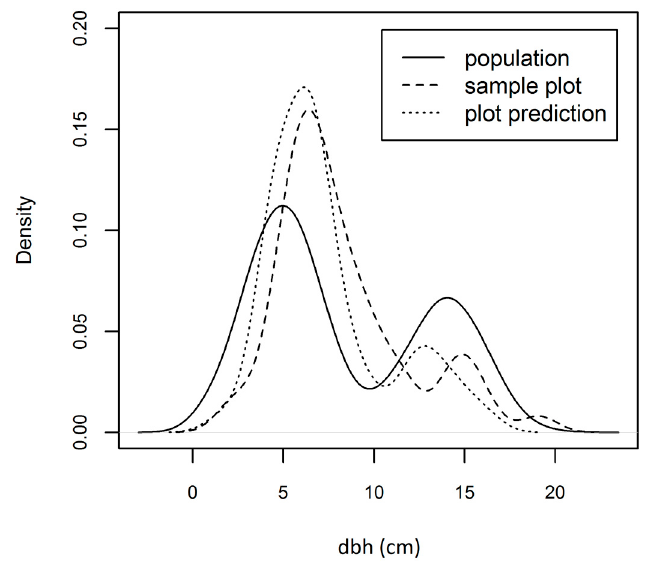
Figure 4. Probability density function of simulated mixture distribution used for testing overlaid with the predicted distribution for a simulated plot, and the observed measurements for the simulated plot.